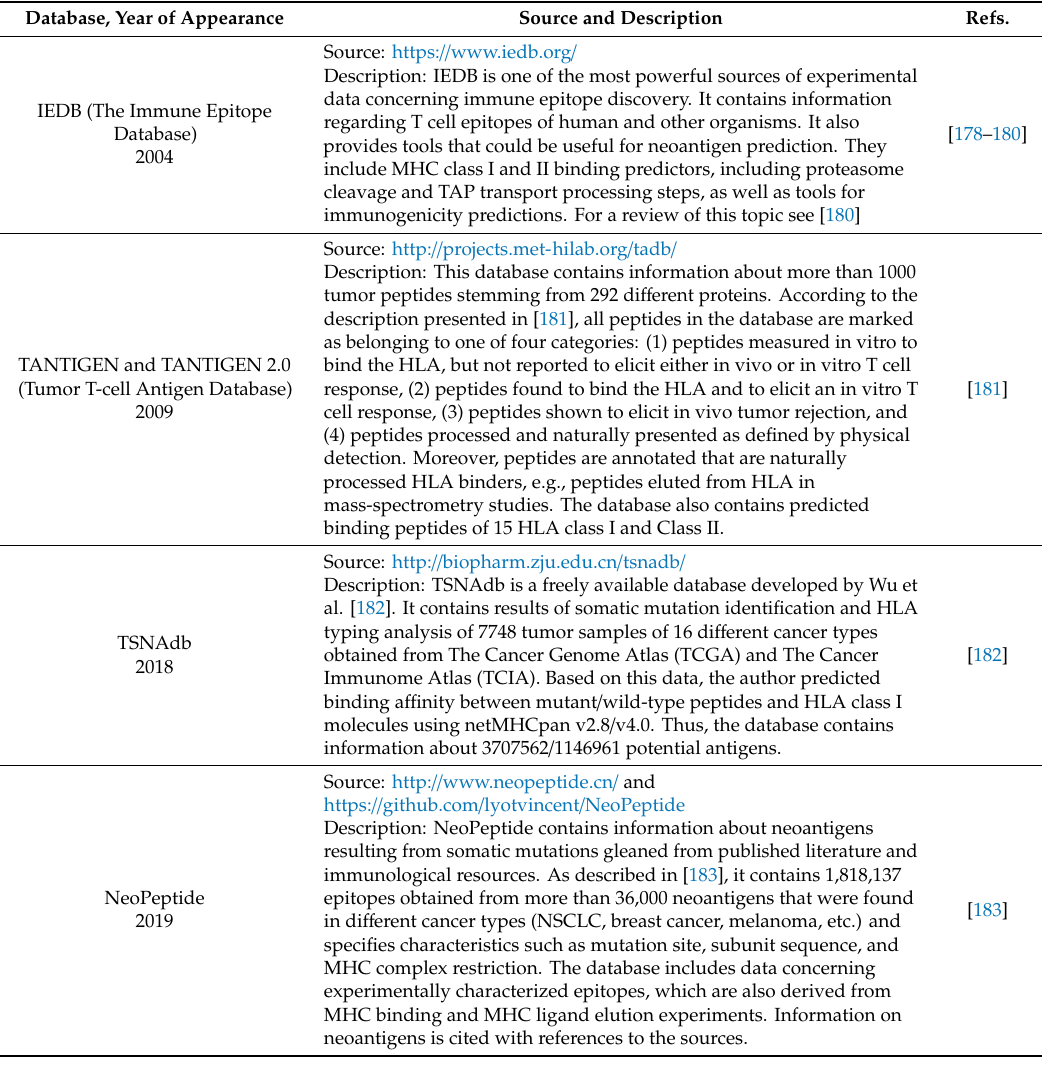
Table 2. Selected databases containing information related to tumor neoantigens *. Source and Description